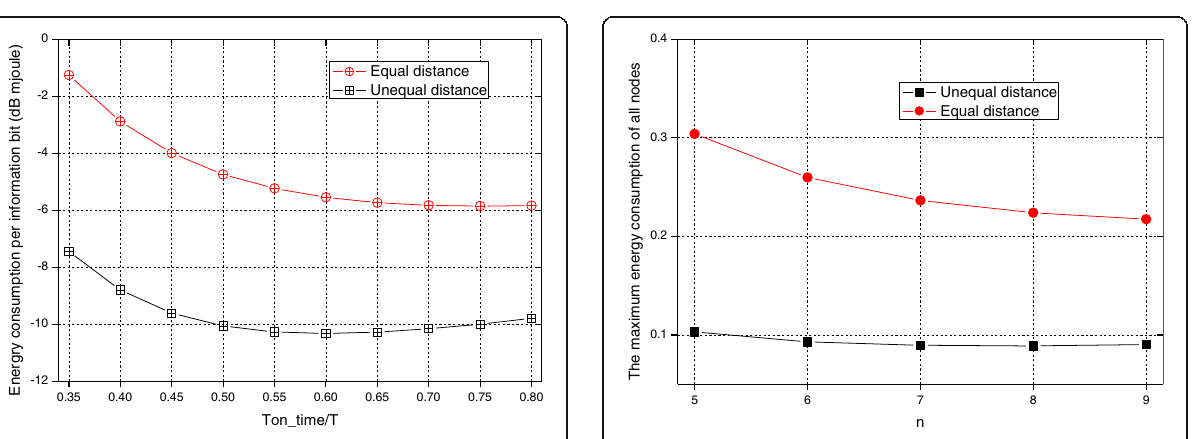
Fig. 36 The maximum energy consumption at optimal duty cycle under UDNP and EDNP (MPSK)